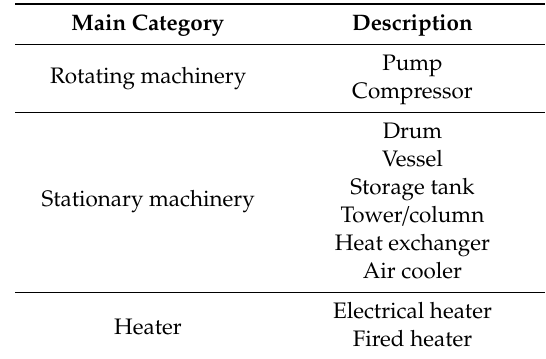
Table 7. Item classification for the standardized process